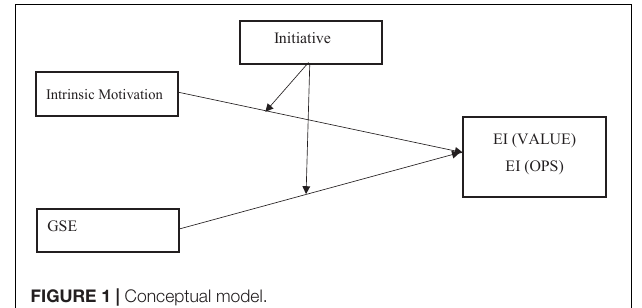
FIGURE 1 | Conceptual